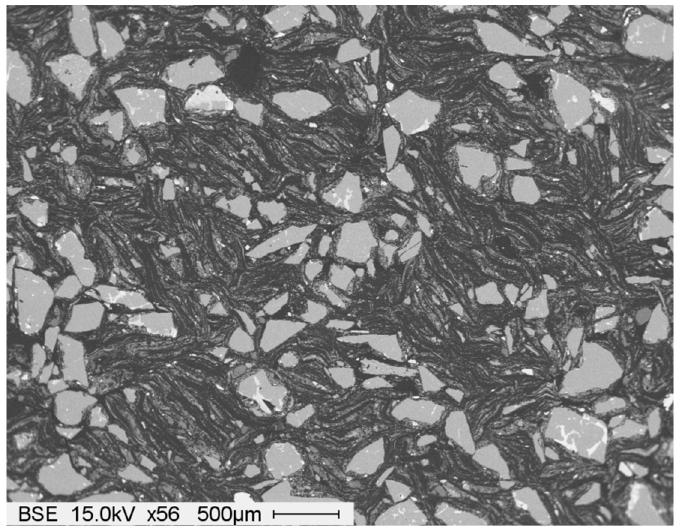
Figure 8. Microstructure of pressed powder.